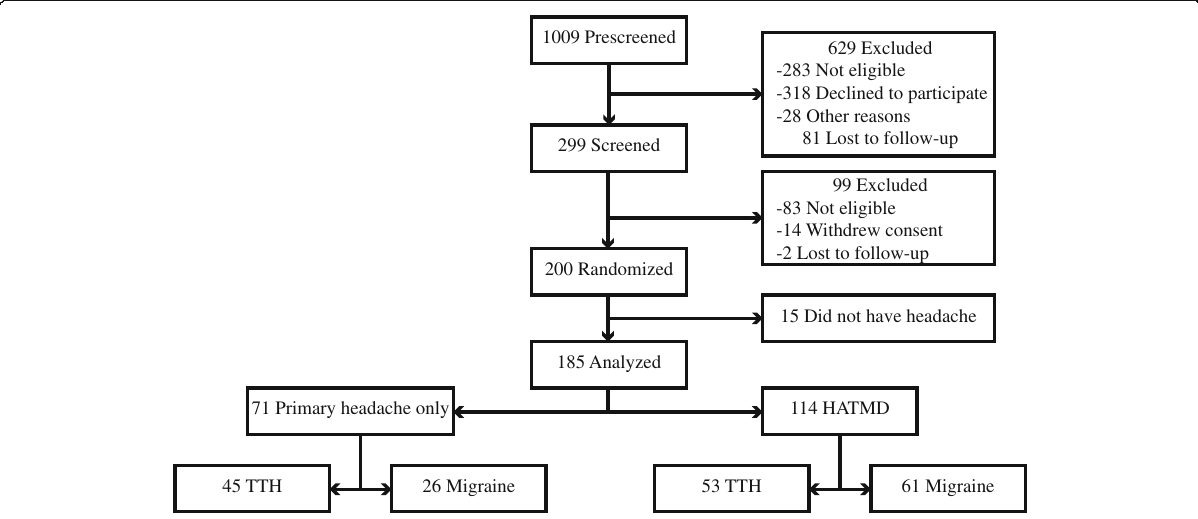
Fig. 1 Flowchart. Abbreviations: HATMD, headache attributed to TMD; TTH, tension-type